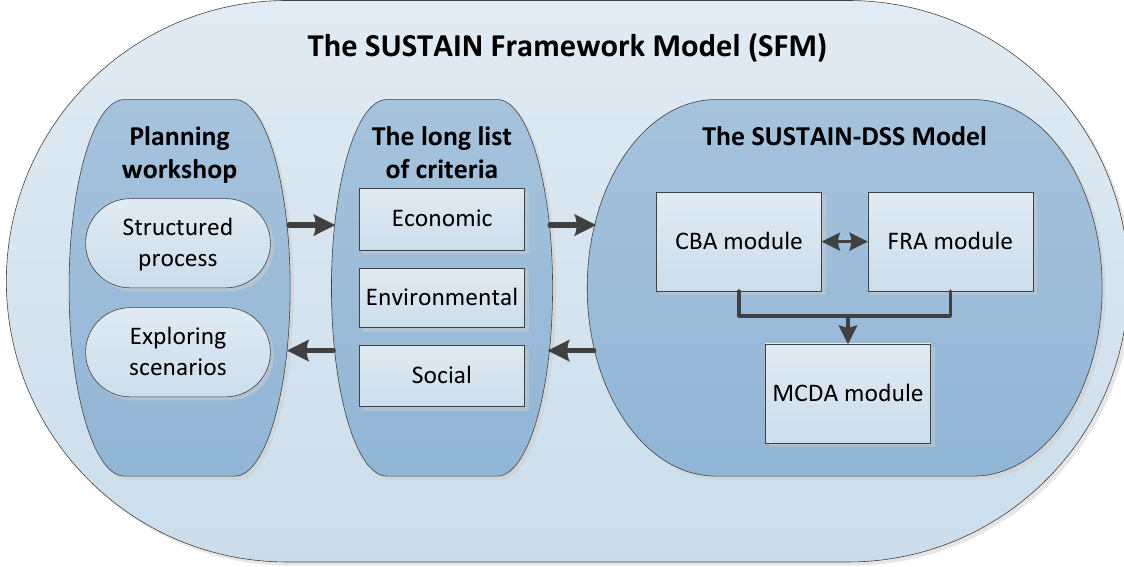
Figure 3. The SUSTAIN Framework Model indicated by its main